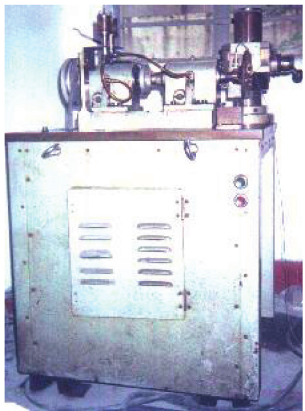
Figure 4: The test rig of the first